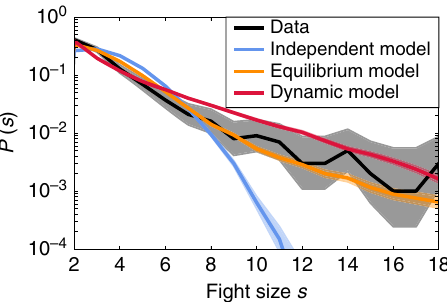
Figure 1 | Testing fit of fight-joining processes to individual-level data. Models that include social correlations (the equilibrium maximum entropy and dynamic branching process models) can reproduce the relatively long tail of the observed distribution of fight sizes, whereas assuming independent fight-joining events (the independent model) cannot. Shaded regions indicate 95% confidence